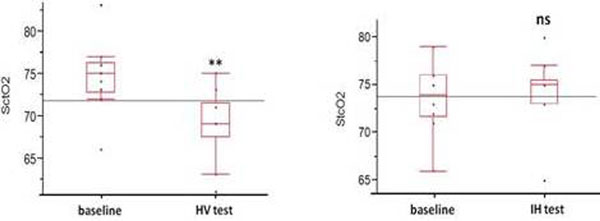
Changes in SctO2 after moderate HV and IH tests (n = 10 patients).